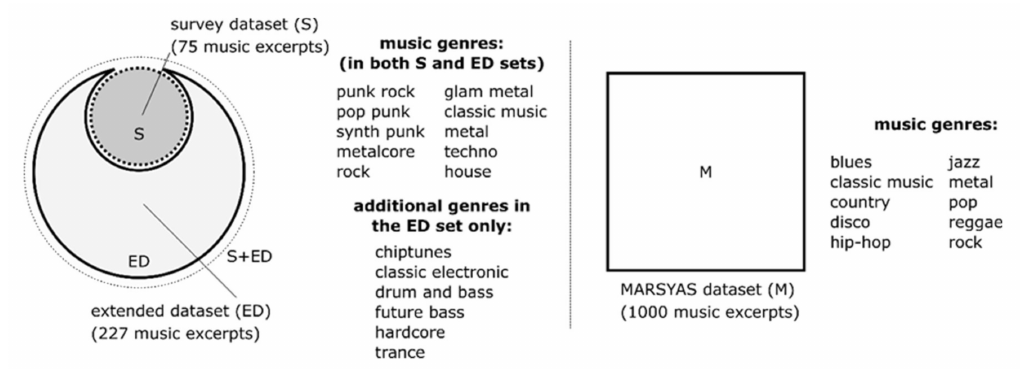
Figure 5. Illustration of datasets gathered for the study. The dataset used for conducting surveys (S) is a subset of the (S + extended dataset (ED)) dataset. The extended (ED) and MARSYAS datasets were employed for training machine learning